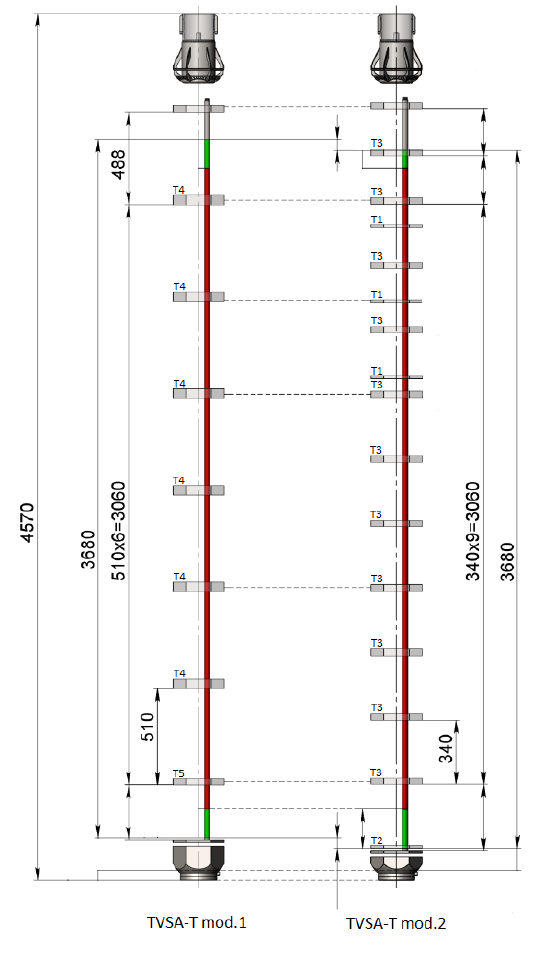
Figure 3. Axial geometry of both types TVSA-T.